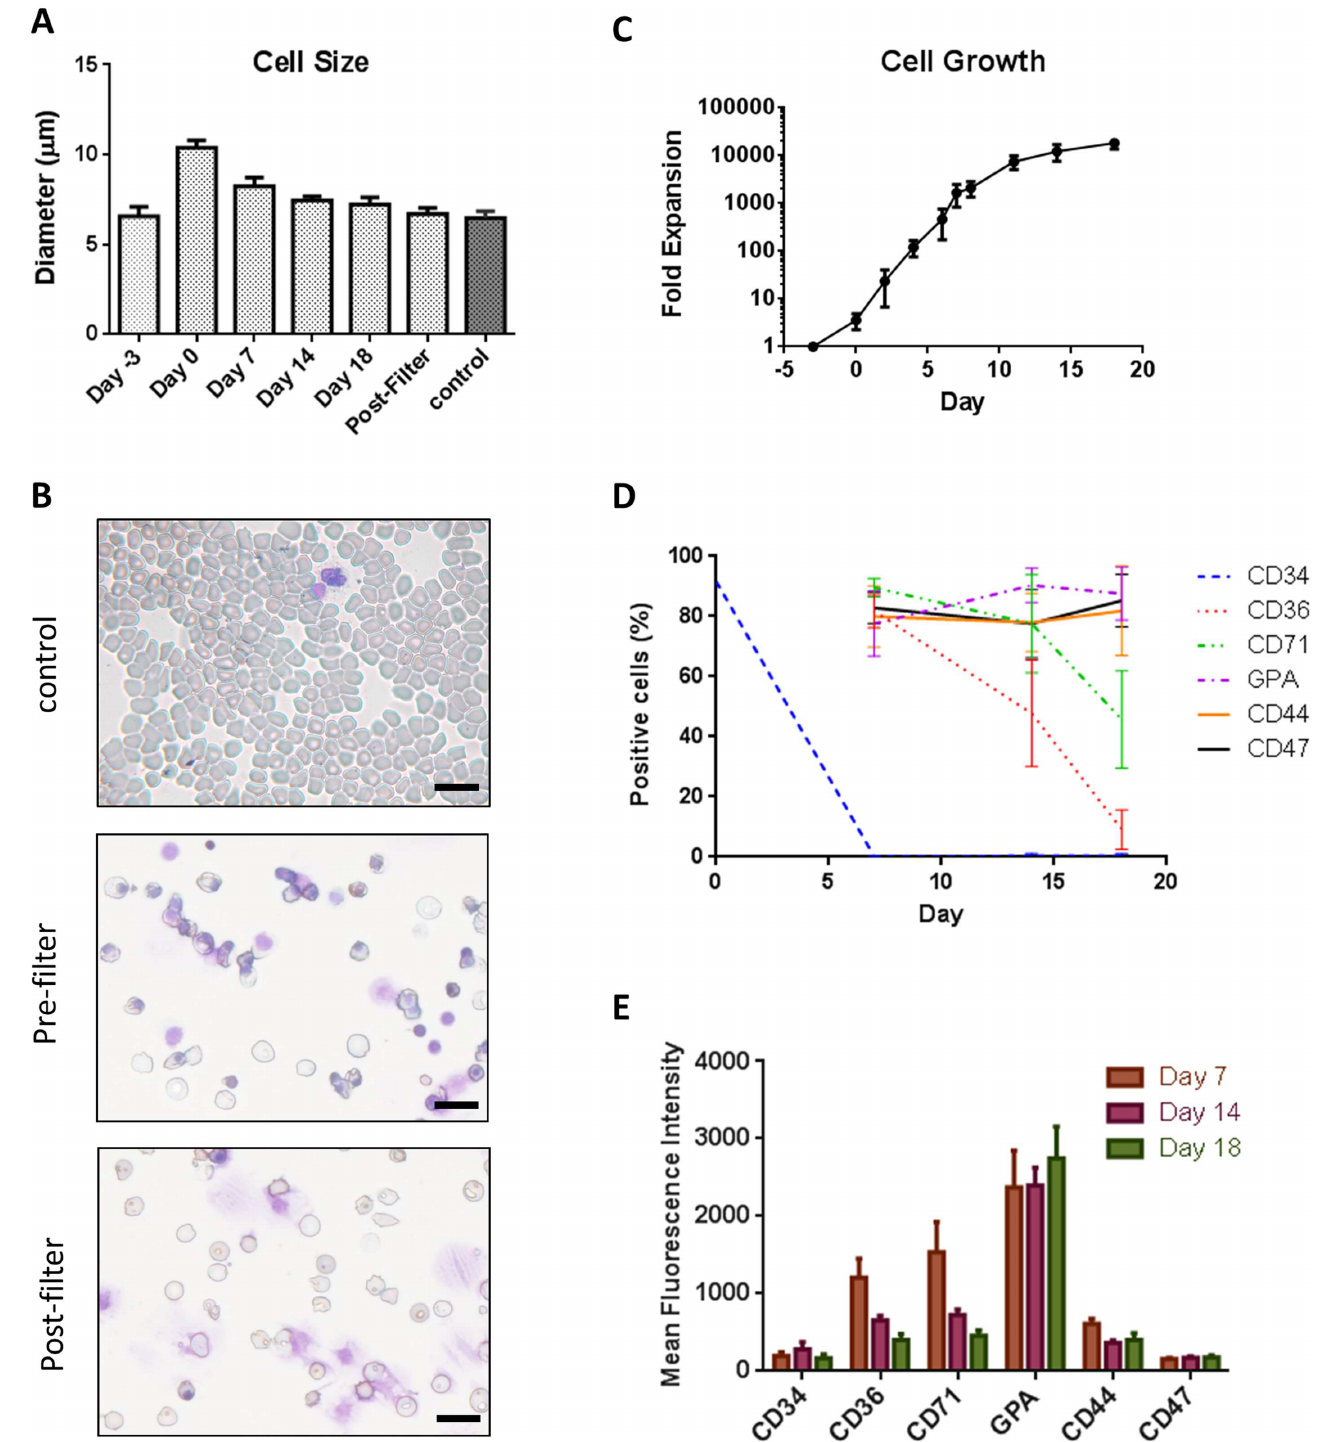
Fig 1. Characterization of stemRBCs. (A) Cell diameters of stemRBCs (n = 10) derived from cord blood isolatedCD34 + cells duringdifferentiation from day 0 to day 18 in culture comparedto humancontrol RBCs and filtered cells on day 18. (B) Cell morphology of adult humanblood (control) from cytospins for comparisonwith pre- (NF) and post-filter (F) day 18 stemRBCs. Scale bar represents20 μ m. (C) Total number of viable,non-adherent cells were determinedand plotted as a mean ± SE of 4 cultures. (D) Frequency of cells expressingseveralerythroid markers as determined by flow cytometry over an 18 day culture period(mean ± SE) and (E) mean ± SE fluorescence intensities(MFIs) showingexpression patterns of these markers during differentiation (n = 8). doi:10.1371/journal.pone.0166657.g001 PLOS ONE | DOI:10.1371/journal.pone.0166657 December13,